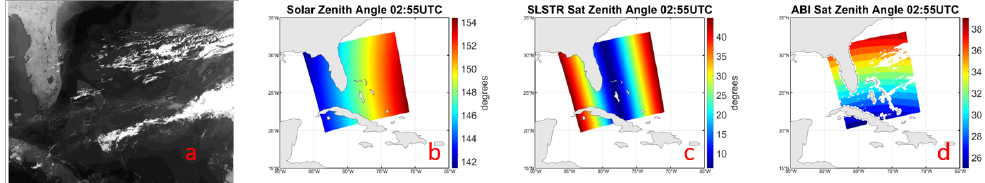
Figure 6. ( a ): SLSTR nighttime false color infrared image of the eastern tropical North Atlantic Ocean coast region on 1 January 2020, 02:55:20 UTC. ( b ): Solar zenith angles at the same time. ( c ): Corresponding SLSTR satellite zenith angles. ( d ): Corresponding ABI satellite zenith angles, only the points with available ABI matched up pairs are